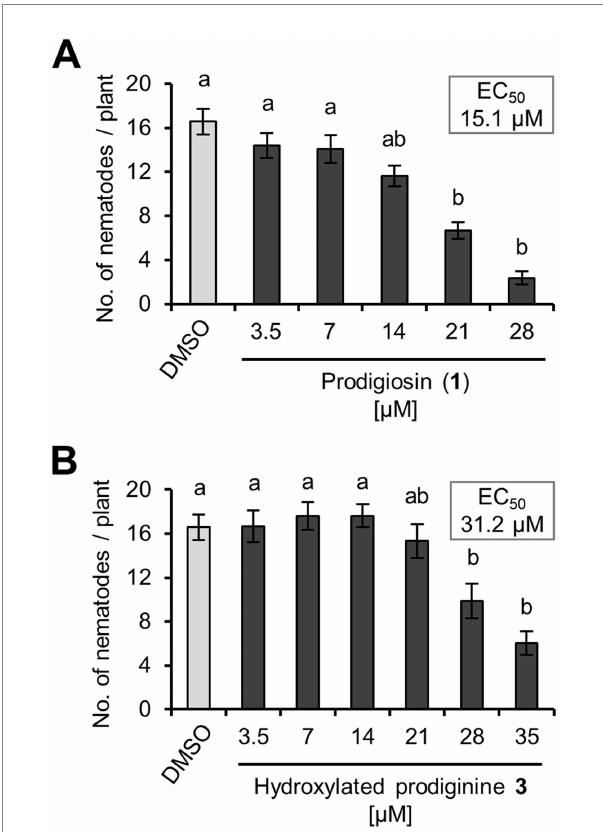
FIGURE 5 EC 50 determination of prodiginines on the plant-parasitic nematode Heterodera schachtii . (A) Impact of prodigiosin ( 1 ) on nematodal plant infestation. (B) Impact of hydroxylated prodiginine 3 on nematodal plant infestation. The impact on H. schachtii was assessed as reduction of nematode numbers on Arabidopsis thaliana . EC 50 values (effective concentration that causes a reduction of nematode infestation of A. thaliana by 50%) were calculated by using ‘CompuSyn’. Results are expressed as the mean ± standard error of three independent biological replicates ( n ≥ 18). Different letters indicate statistically significant differences among treatments according to Dunn’s Method ( p <